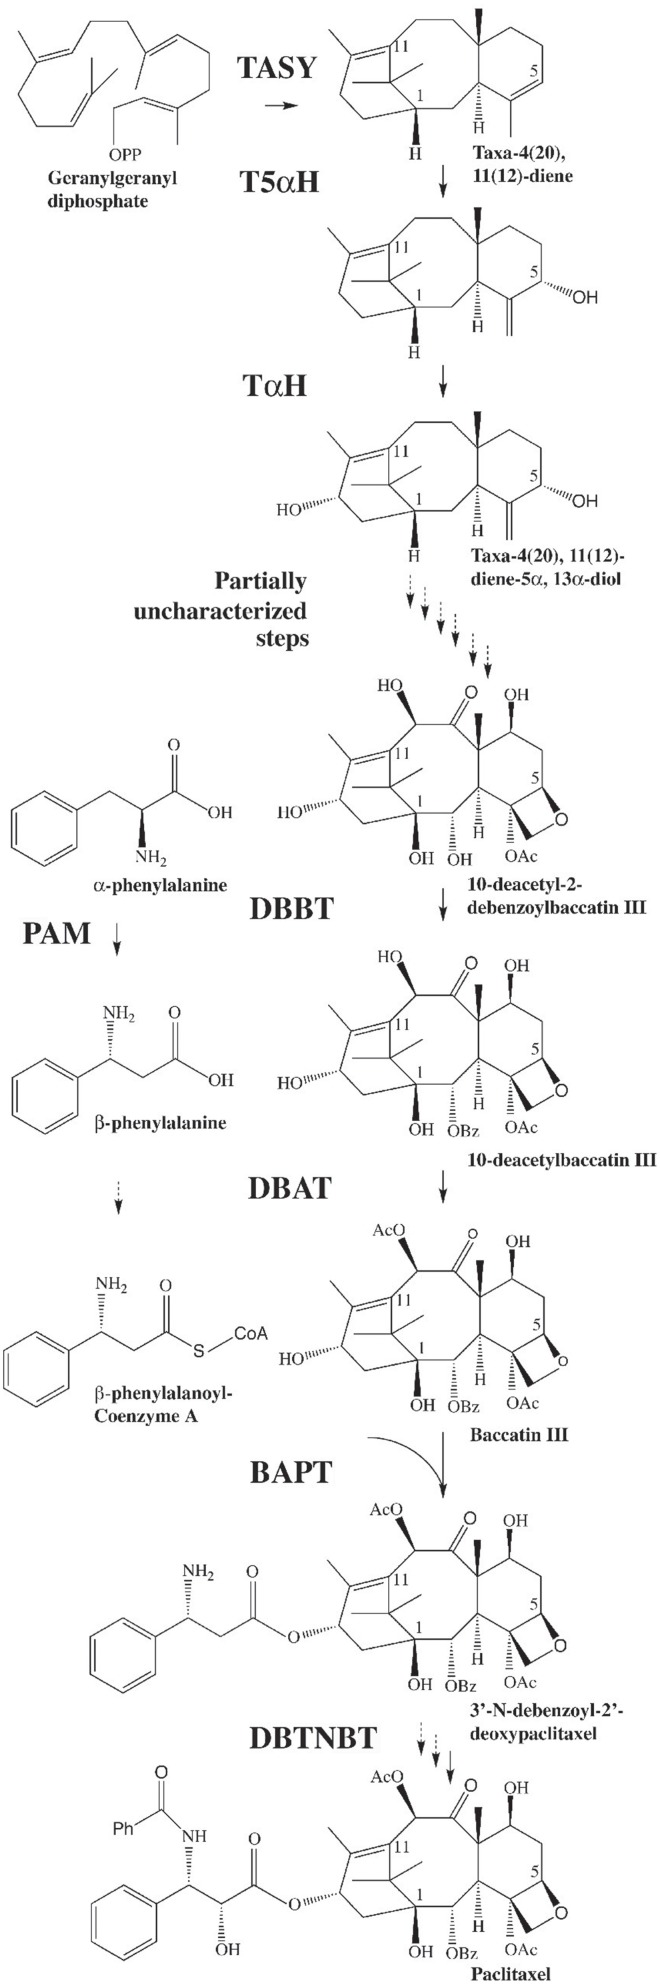
The biosynthetic pathway leading to paclitaxel. GGPP is synthesized by geranylgeranyl diphosphate synthase (GGPPS). GGPP is then converted to taxadiene by taxadiene synthase (TASY) (Wildung and Croteau, 1996) and then to taxadien-5α-ol by taxadien-5α-ol hydroxylase (T5α H) (Jennewein et al., 2004a). Several steps leading from the diol intermediate to functionalized taxanes, including the formation of the oxetane ring, are unknown. Taxane 2α-O-benzoyltransferase (DBBT) (Walker and Croteau, 2000b) produces 10-deacetylbaccatin III (10-DAB). 10-DAB is then converted to baccatin III by 10-deacetylbaccatin III-10-O-acetyltransferase (DBAT) (Walker and Croteau, 2000a). Baccatin III: 3-amino, 3-phenylpropanoyltransferase (BAPT) ligates the side chain [derived from phenylalanine via phenylalanine aminomutase (PAM) (Jennewein et al., 2004b)] to produce 3′-N-debenzoyl-2-deoxypaclitaxel (Walker et al., 2002a). An unknown P450-mediated hydroxylation of the side chain forms 3′-N-debenzoyl paclitaxel. 3′-N-debenzoyl-2-deoxypaclitaxel-N-benzoyltransferase (DBTNBT) then produces paclitaxel by benzoylation of the side chain (Walker et al., 2002b).